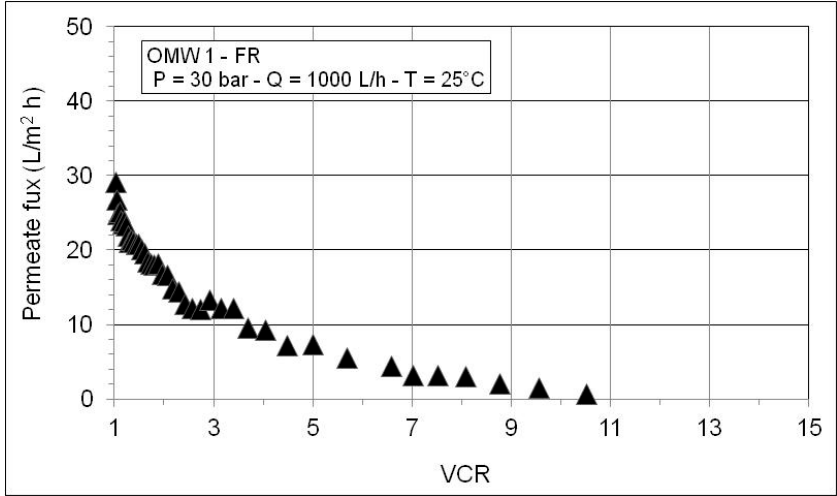
Figure 5. Permeate flux as a function of VCR during RO test with the MF permeate of OMW1-FR.